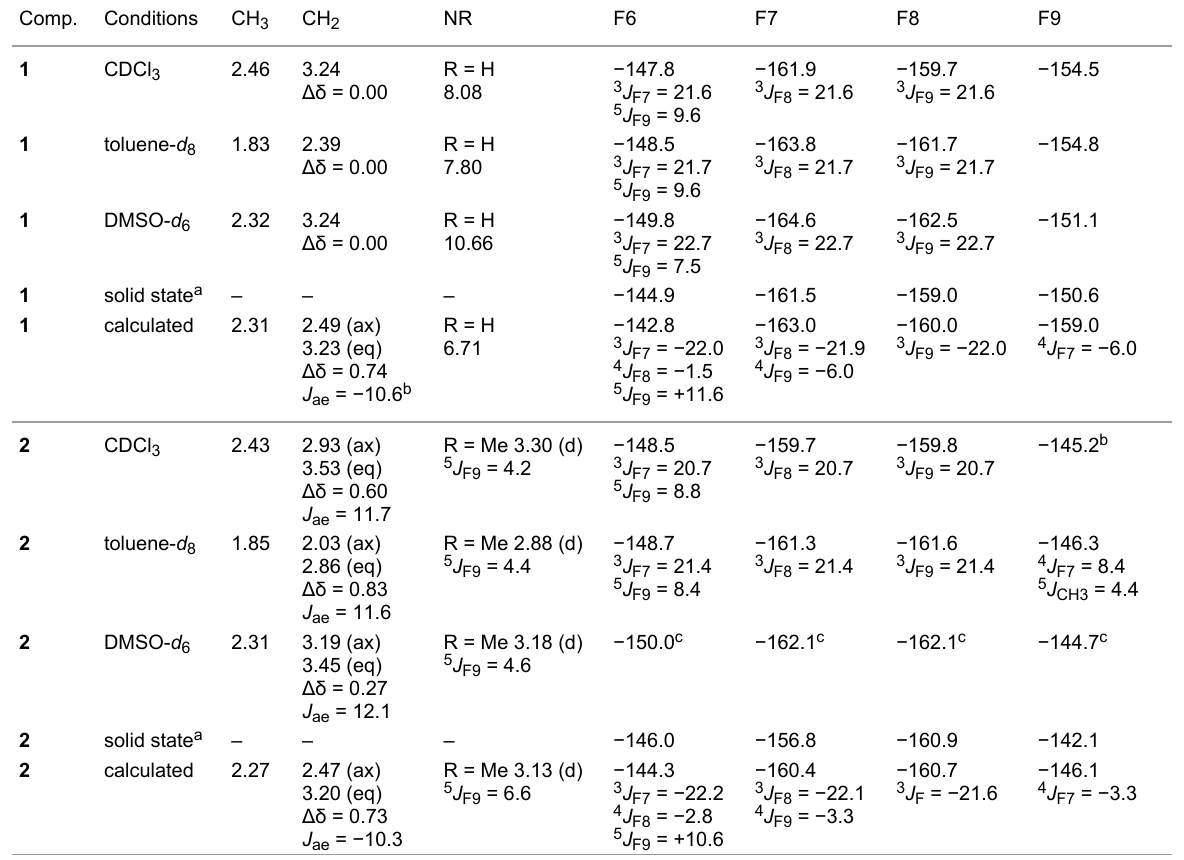
Table 2: 1 H and 19 F chemical shifts ( δ , ppm, Δδ = δ eq − δ ax ) and SSCC ( 1 H– 1 H; 1 H– 19 F; 19 F– 19 F Hz) of compounds 1 and 2 at 300 K together with the calculated values in ppm and Hz.